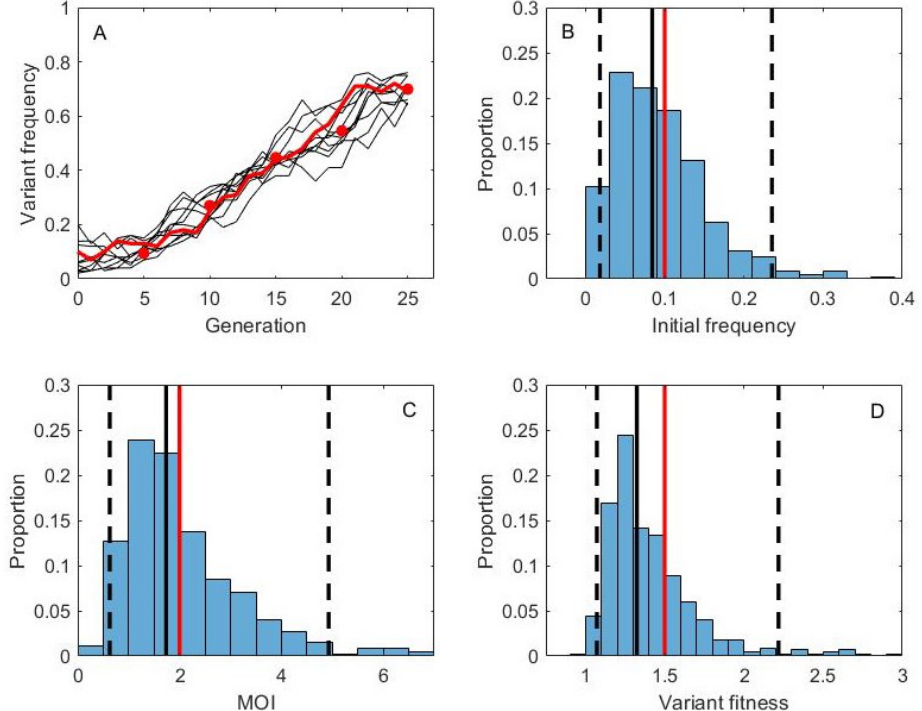
Figure 5. Variant fitness estimation under the assumption of stochastic evolutionary dynamics. ( A ) Mock data (red dots) generated from a forward simulation of the stochastic within-host evolution model with added measurement noise. The under- lying stochastic dynamics are shown with a red line. The model is parameterized with variant fitness of e σ m = 1.5, a mean cellular MOI of M = 2.0, an initial frequency of the variant of q m ( t 0 ) = 0.10. Measurement (observation) noise is set to ν = 100. The viral effective population size is set to N = 100. Grey lines show the dynamics of 10 reconstructed allele frequency trajectories. These trajectories are unobserved state variables that have been reconstructed using pMCMC. ( B ) Posterior distribution for the initial frequency of the variant. ( C ) Posterior distribution for the mean cellular multiplicity of infection M . ( D ) Posterior distribution for variant fitness. In ( B – D ), black solid lines show the median values of the posterior densities, black dashed lines show the 95% credible intervals, and red solid lines show the true values. 200 particles were used in the